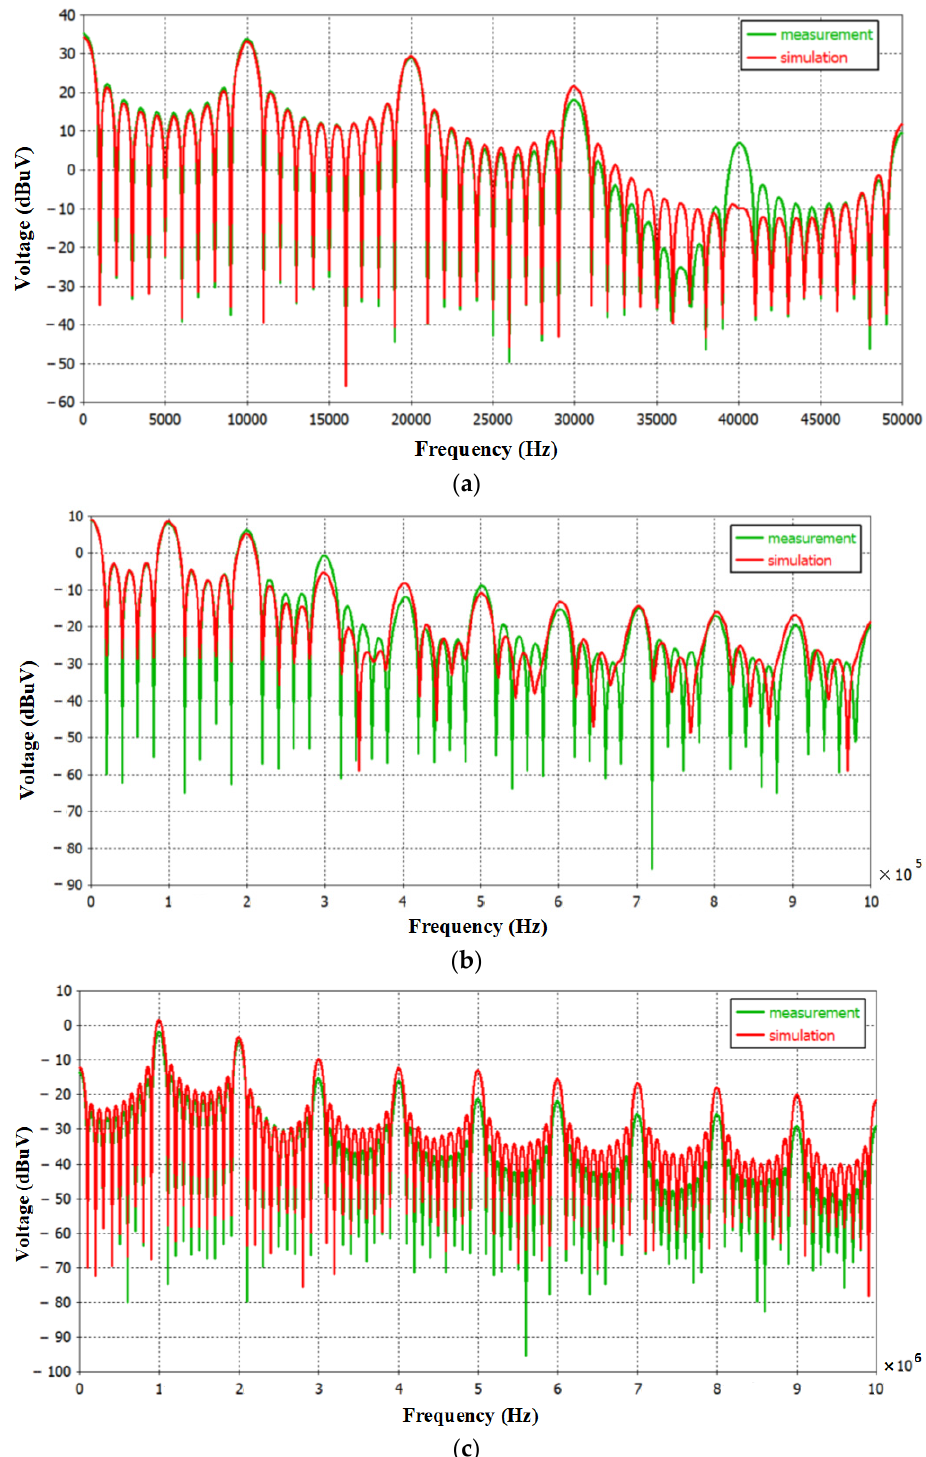
Figure 21. Frequency domain comparison of measured and simulated results: ( a ) 10 kHz; ( b ) 100 kHz; ( c ) 1 MHz.